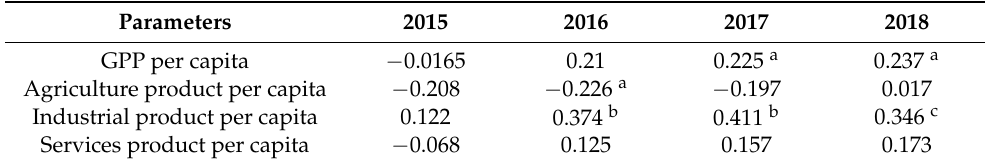
Table 2. Spearman’s correlation coefficients between SSS coverage among all migrants and economic level by all sectors, during 2015–2018.